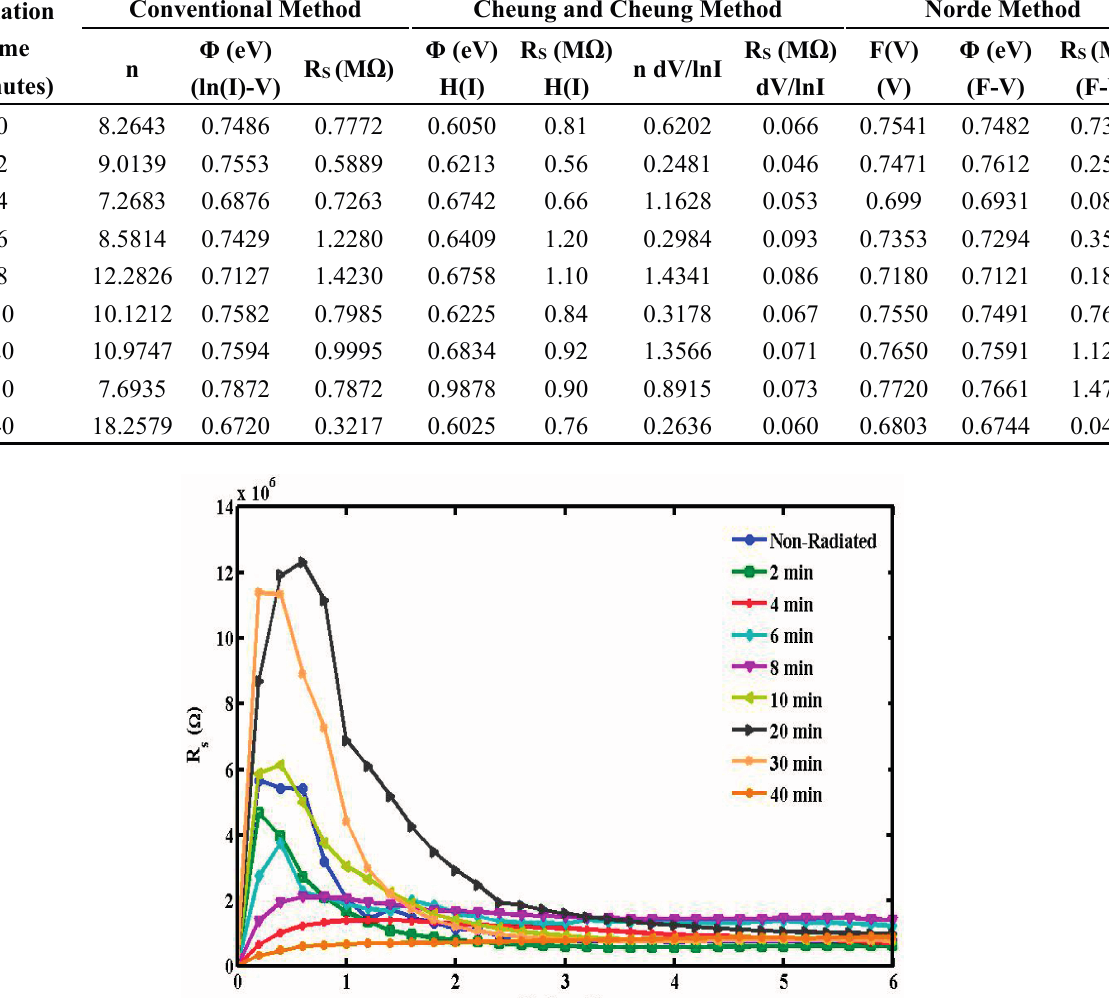
Figure 4. Relation between series resistance and voltage measured using the conventional